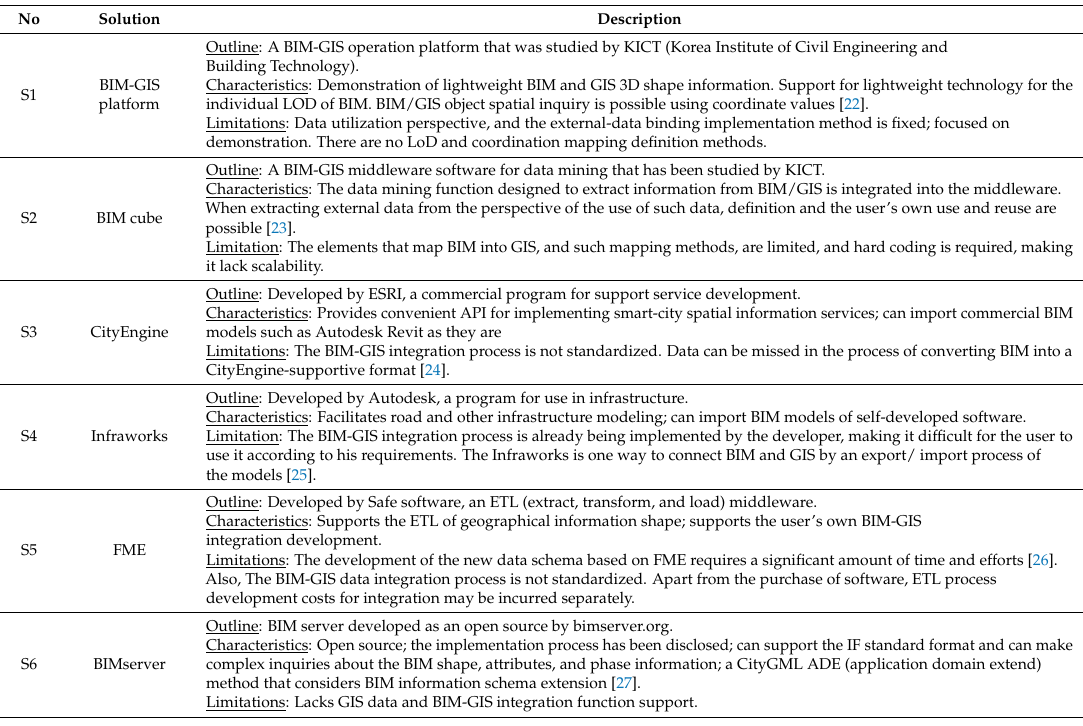
Table 7. Comparison of the BIM-GIS integration technology